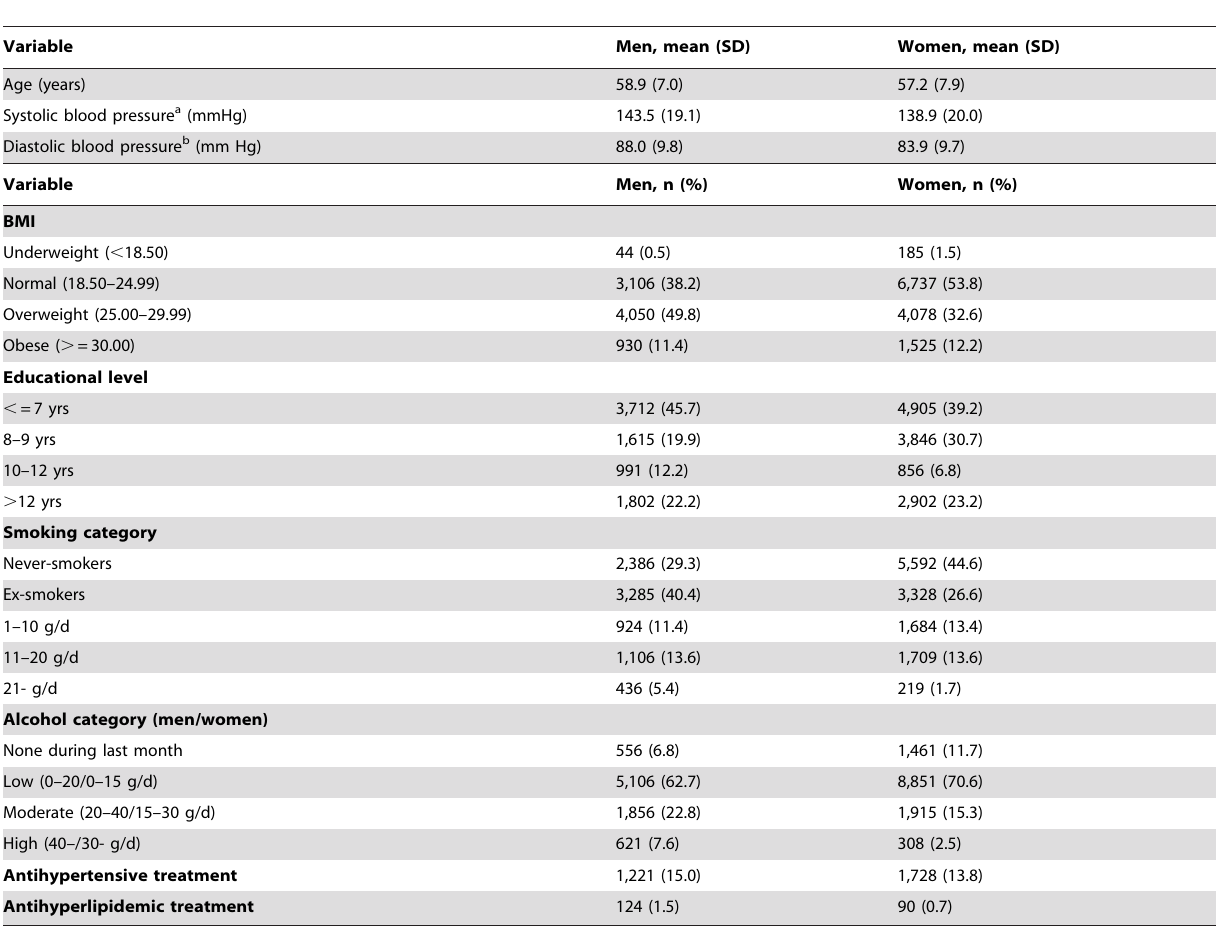
Table 1. Selected background characteristics of participants of the Malmo¨ Diet and Cancer cohort with stable dietary